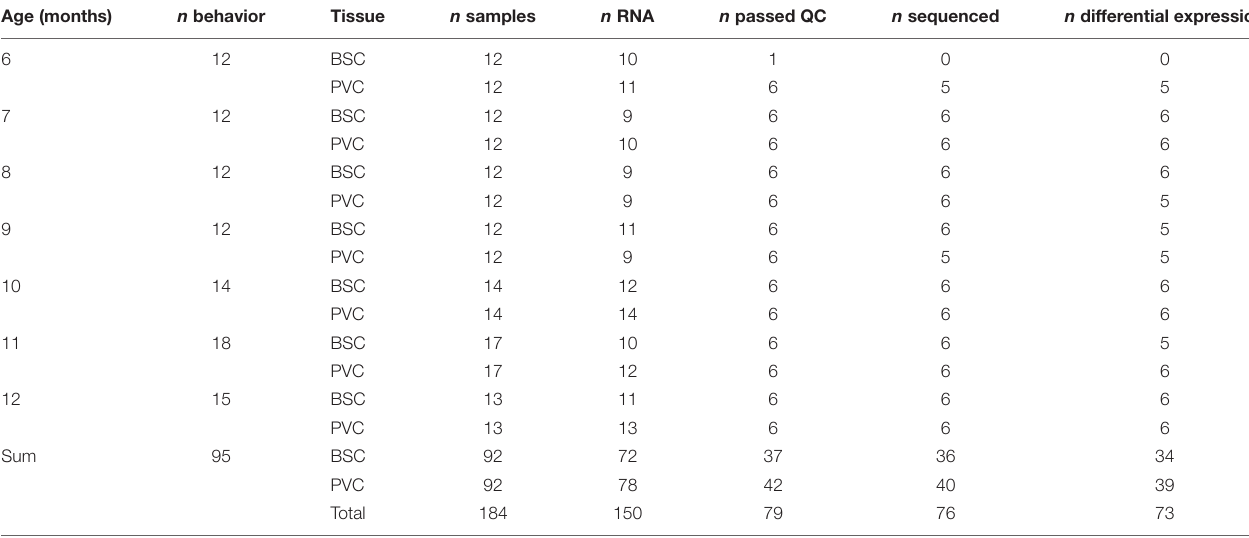
TABLE 1 | Number of individuals used for each step of the experimental process. Age